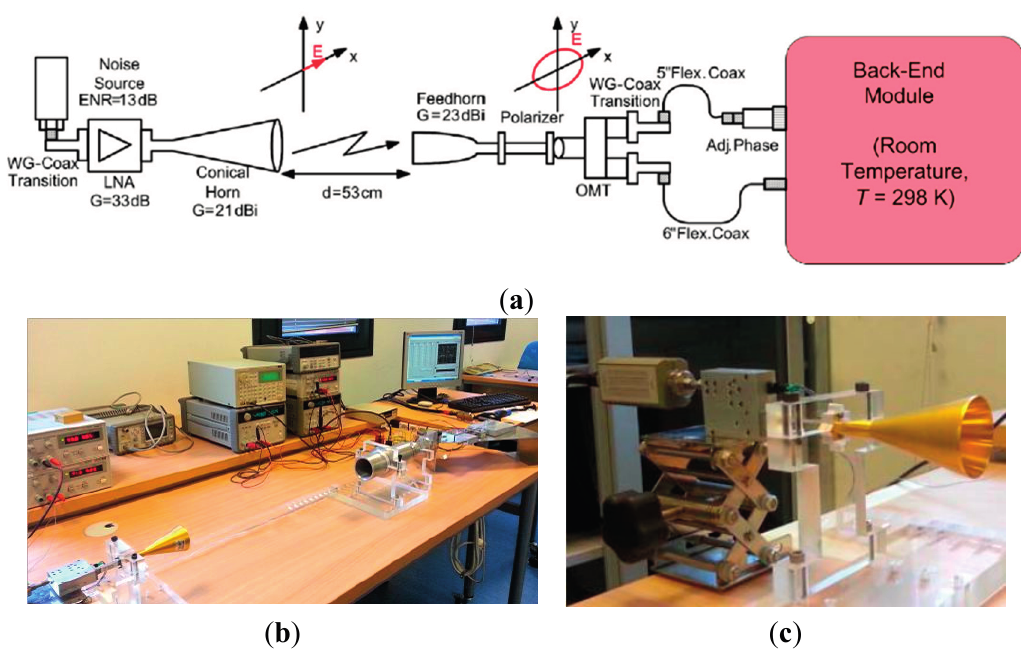
Figure 2. TGI Polarimeter measurement test bench. ( a ) Receiver functionality test bench (BEM details in Figure 1). ( b ) Polarimeter test bench with x -axis linearly polarized source. ( c ) y -axis polarized